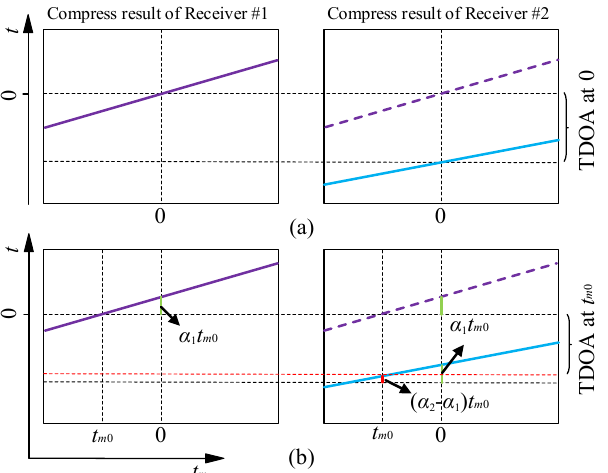
Figure 3. TDOA at different azimuth times. ( a ) With reference pulse at zero time, ( b ) With reference pulse at t m 0 .